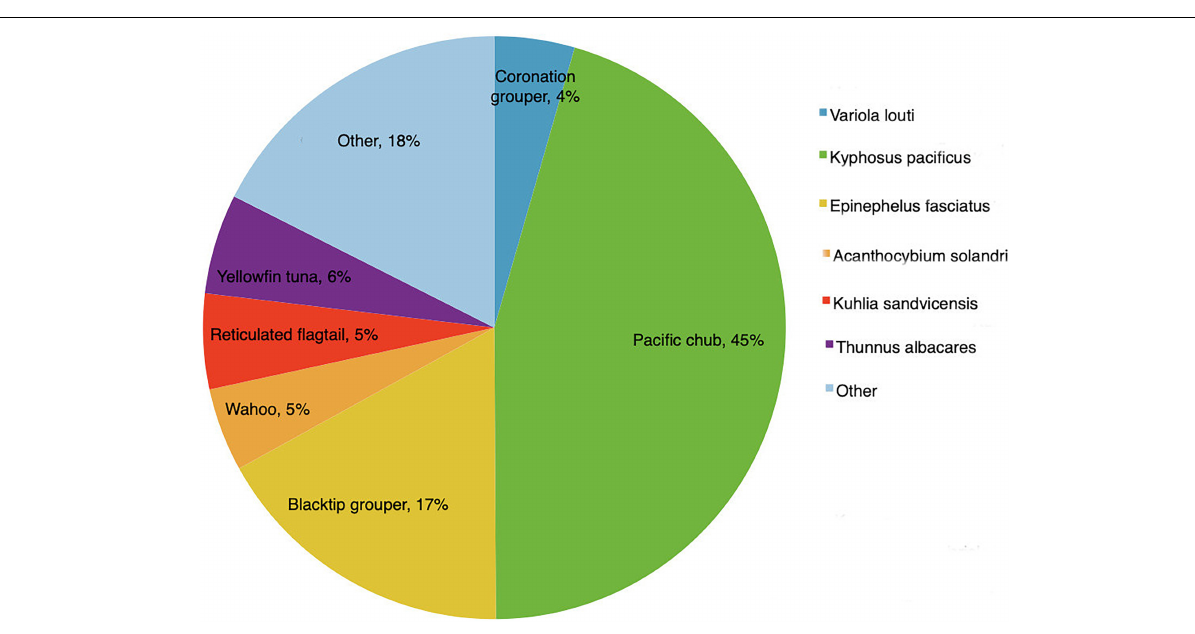
FIGURE 9 | Fish abundance by species, as a proportion of the total catch (after Dawson and Irving,